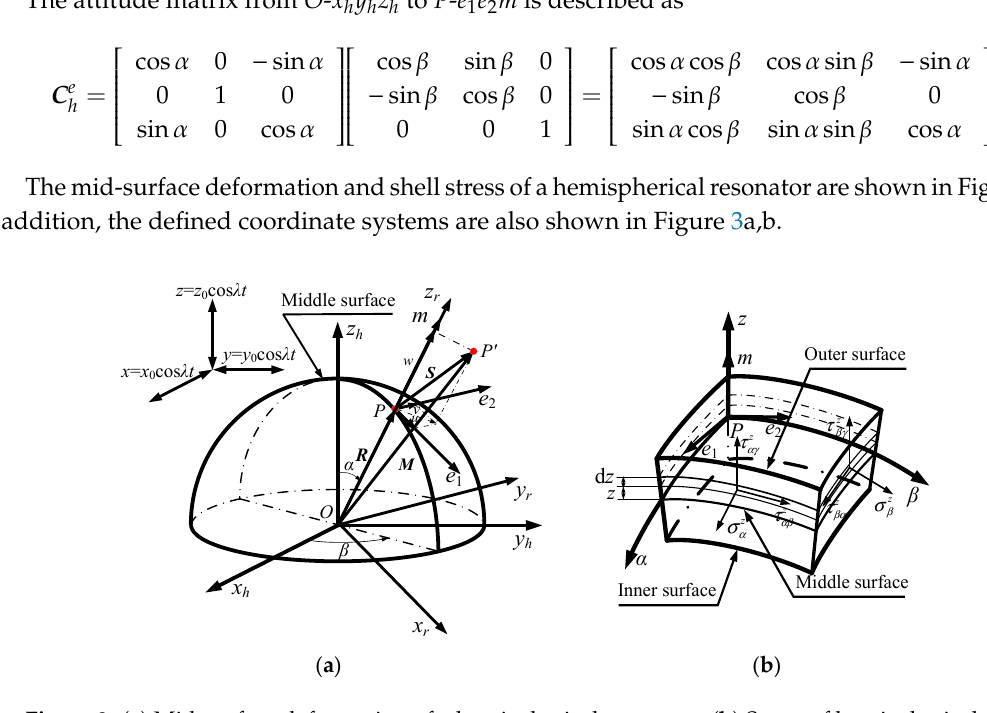
Figure 3. ( a ) Mid-surface deformation of a hemispherical resonator; ( b ) Stress of hemispherical thin shell